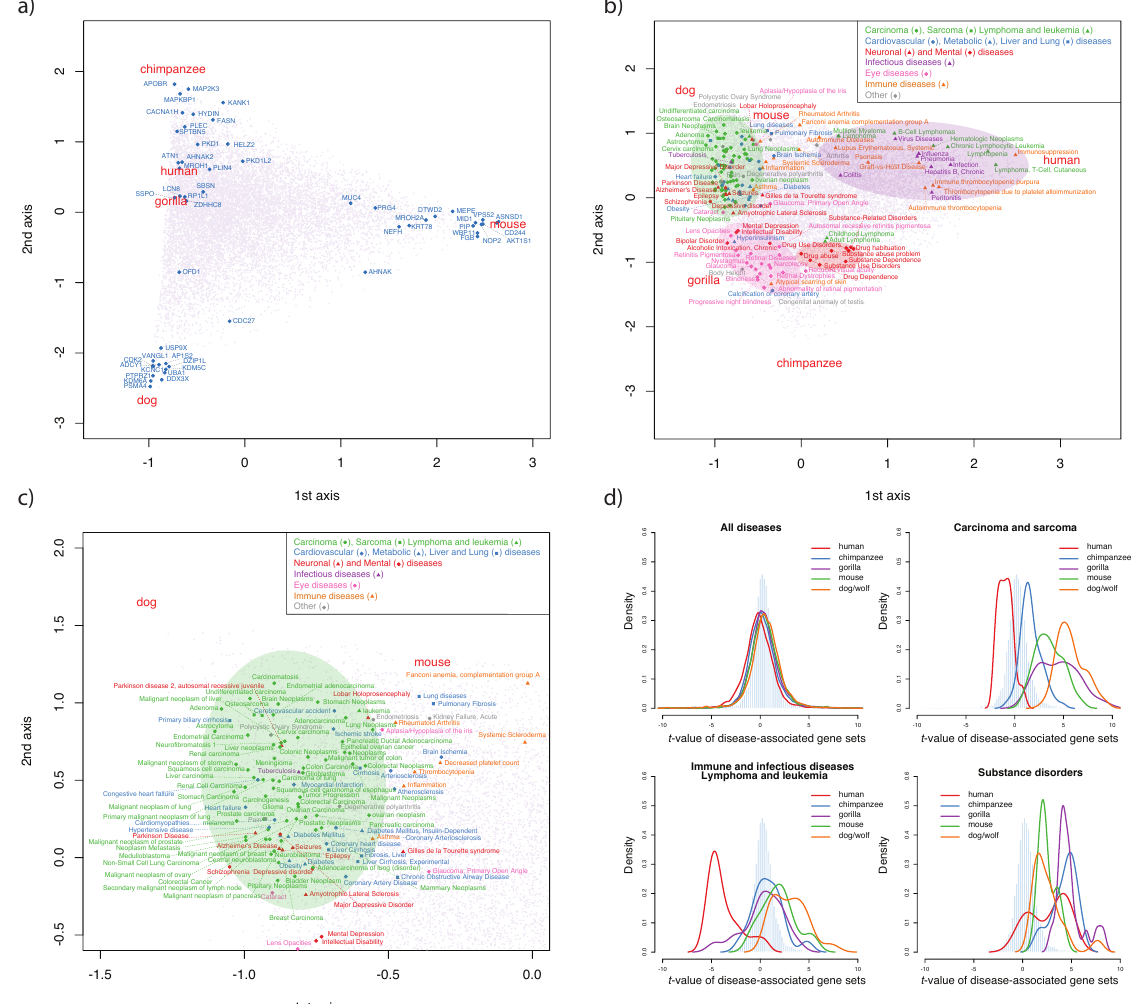
Figure 4. Correspondence analysis of genes and disease-associated gene sets: ( a ). Correspondence ( p ) of each gene. ( b , c ). Correspondence analysis analysis of 14,671 genes of five species using − log 10 ( p ) of each disease-associated of 14,267 disease-associated gene sets of five species using − log 10 gene set. The diseases highlighted are significant diseases with a false discovery rate of 0.01. ( d ). Distribution of t -values of all diseases and significant disease-associated gene sets detected by correspondence analysis. The pale blue histogram indicates the distribution of average t -values of five species for each